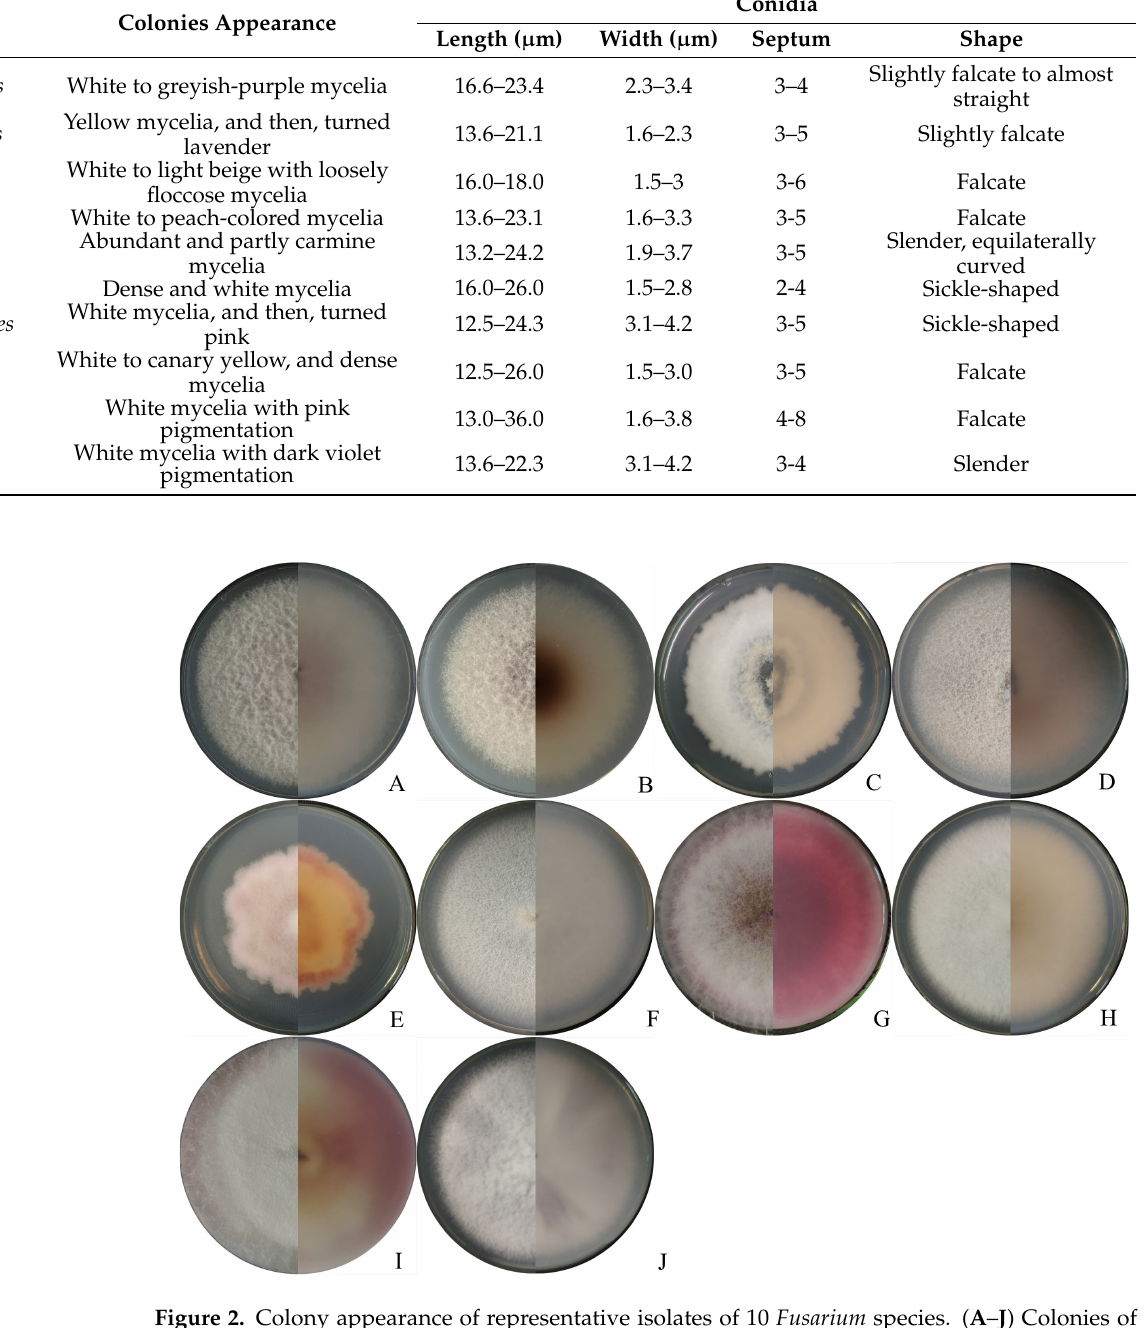
Twenty-five isolates initially produced yellow mycelia, and then, turned lavender; these were identified as the F. subglutinans morphological group. The macroconidia were slightly falcate and septate, with three to five transverse septa, in a size range of 13.6–21.1 × 1.6–2.3 μ m ( n = 30). Nineteen isolates forming white to light beige with loosely floccose mycelia and pro- ducing light yellow pigmentation were classified into the FIESC morphological group. The macroconidia were falcate, with three to six transverse septa and in a size range of 16–18 × 1.5–3 μ m ( n = 30). Seven isolates forming white to peach-colored mycelia were identified as the F. tem- peratum morphological group. Typical macroconidia were falcate, with three to five septa, and in a size range of 13.6–23.1 × 1.6–3.3 μ m ( n = 30). Four isolates forming abundant and partly carmine mycelia were identified as the F. acuminatum morphological group. The macroconidia were slender, equilaterally curved, septate with three to five transverse septa, and in a size range of 13.2–24.2 × 1.9–3.7 μ m ( n = 30). Three isolates forming dense and white mycelia were classified into the F. solani